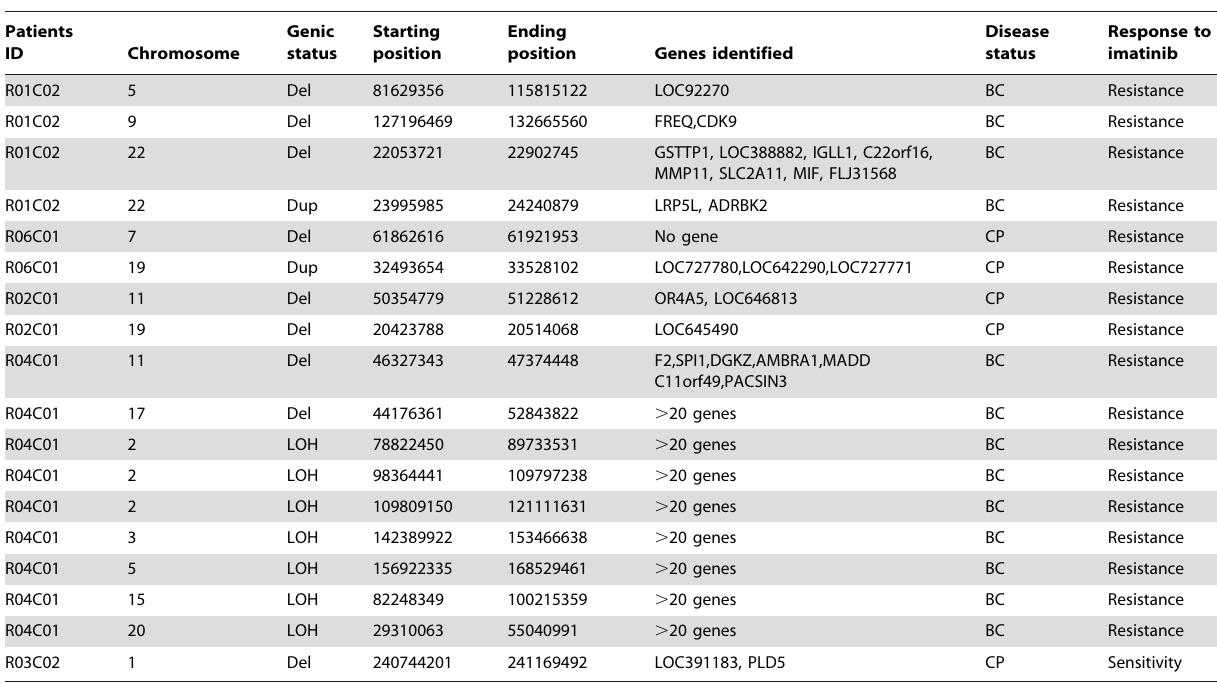
Table 2. Lesion detected in CML samples by SNP array analysis.